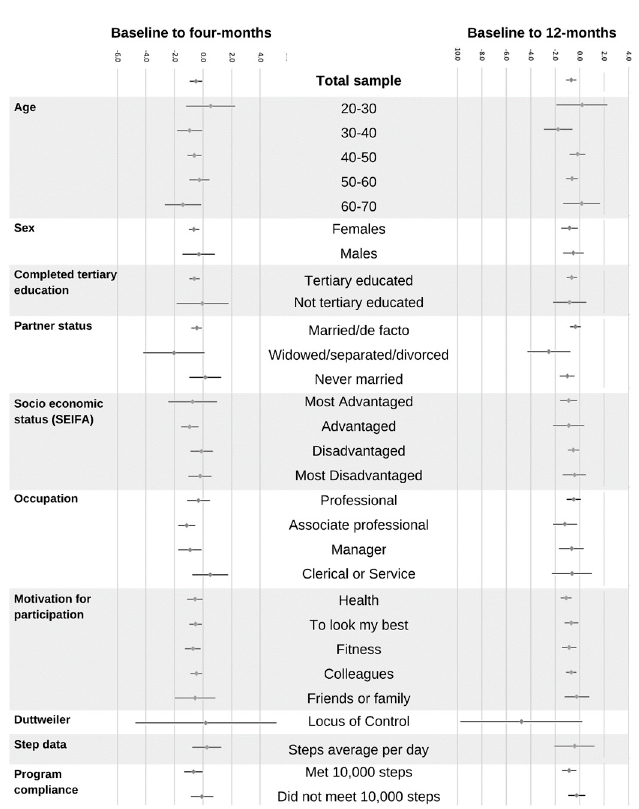
Figure A3. Immediate and sustained change in psychological distress (K10 score) associated with participation in a physical activity workplace program, stratified by demographic, psychosocial and process measures. K10 completed at all three timepoints. Corresponding table Appendix D. Note: vertical line represents no (0) change. Horizontal lines indicate 95% confidence interval minimum to maximum, with the marker indicating mean change in K10